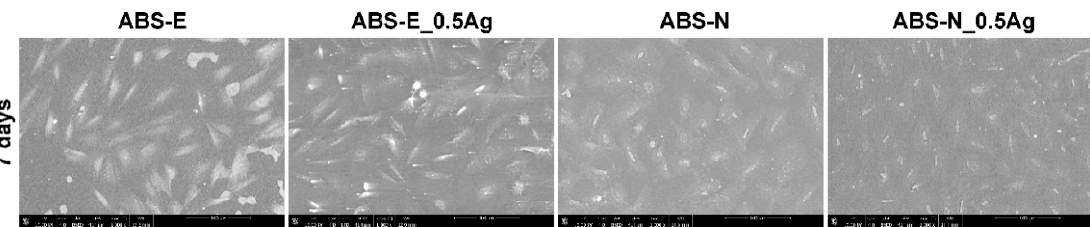
Figure 9. Fluorescence microscope images of Hs680.Tr cells in direct contact with the tested materials. Magnification 20 × .